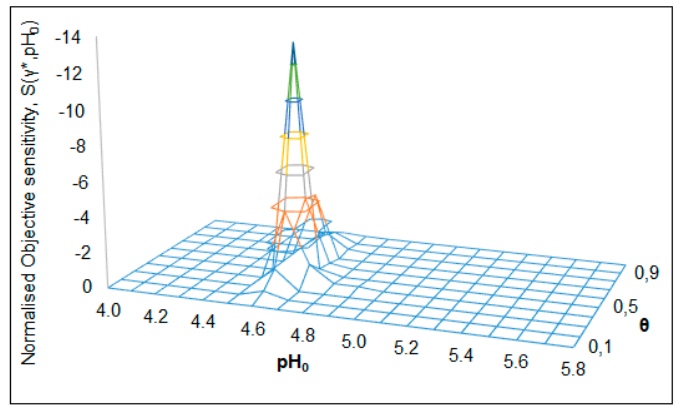
Table 6. Different critical values of input parameters (from Figures 6 to 11).